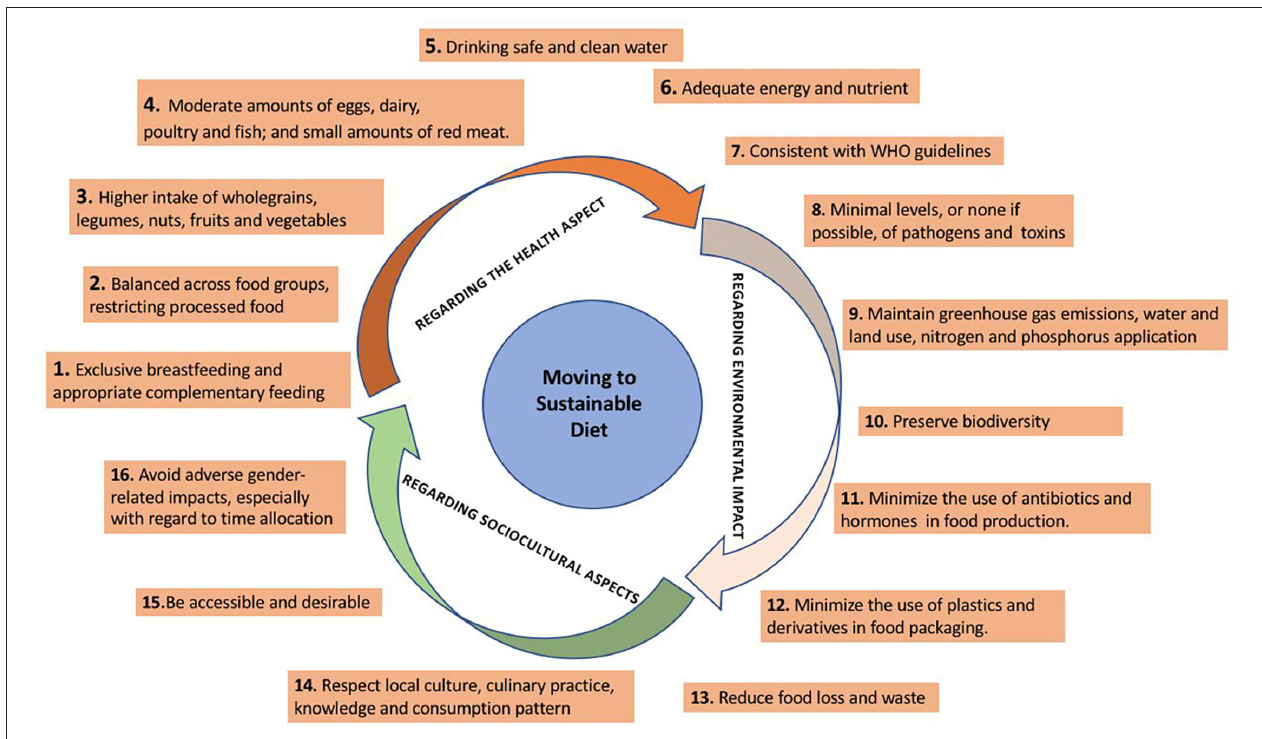
FIGURE 1 | Conceptual framework of shift to a sustainable diet